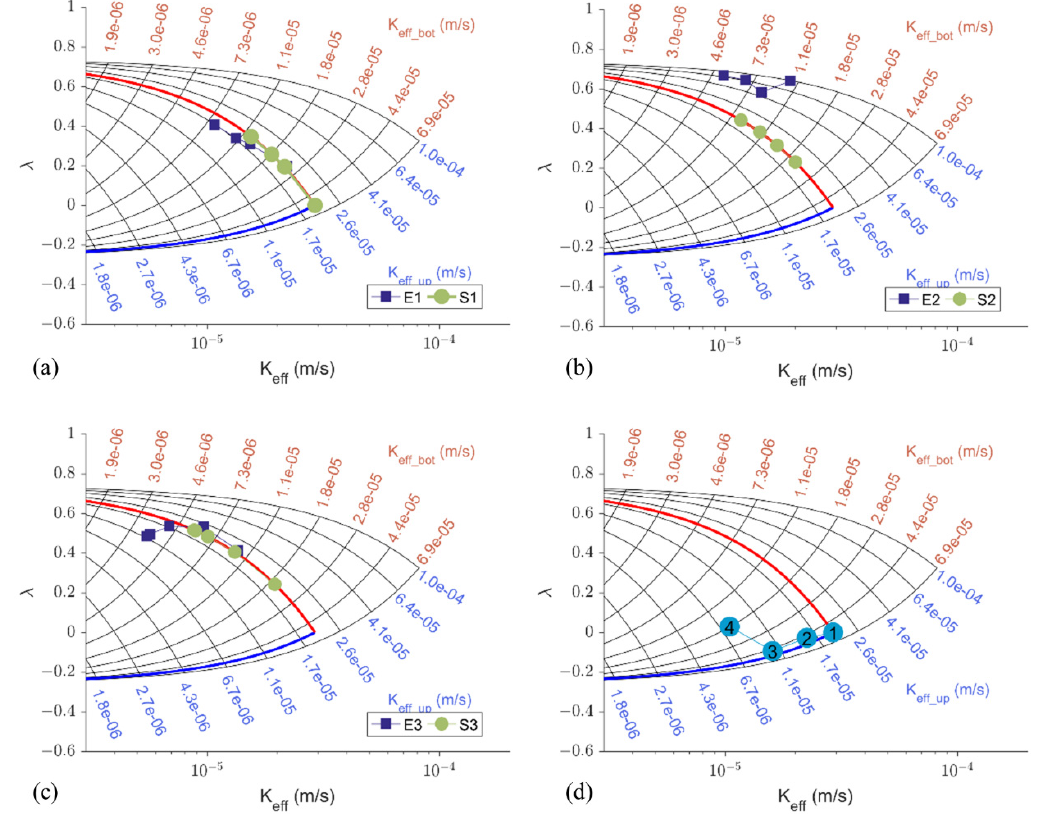
Figure 6. The results of ( a ) S1, ( b ) S2, ( c ) S3, and ( d ) S4. In ( d ), the numbers the circles 1, 2, 3, and 4 are the result of the simulation at h (cid:2936) = 1.5, 1.1, 0.7, and 0.0 m, respectively.